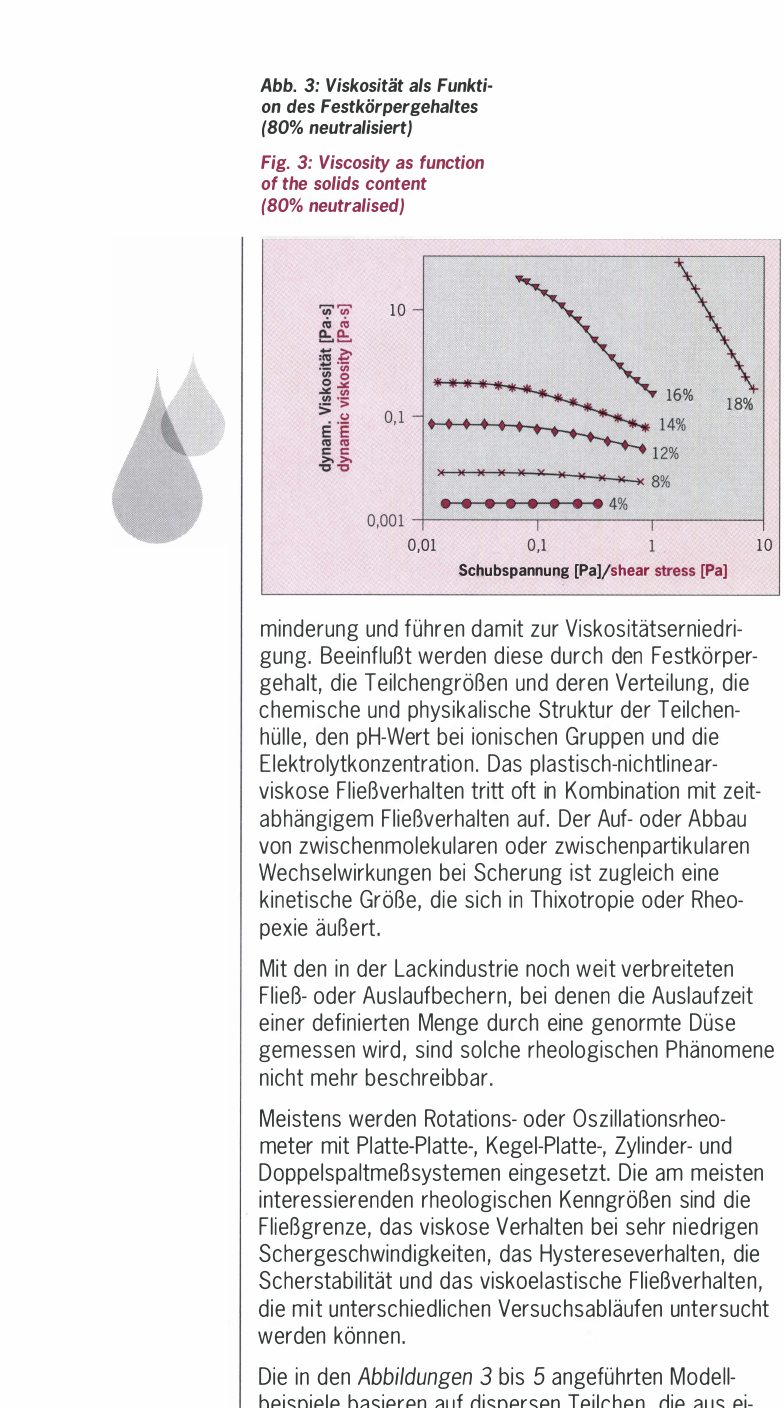
Abb. 4: Einflu/J des pH-Wer­ tes auf die Viskositiit einer Shore-Shell-Dispersion Fig. 4: Effect of the pH value on the viscosity of a Shore shell dispersion